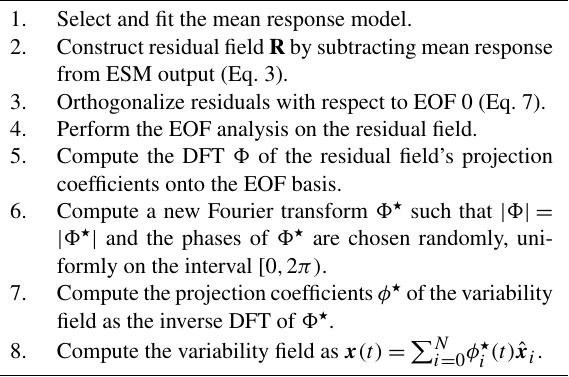
Table 1. Summary of steps in the variability generation algorithm described in Sect.